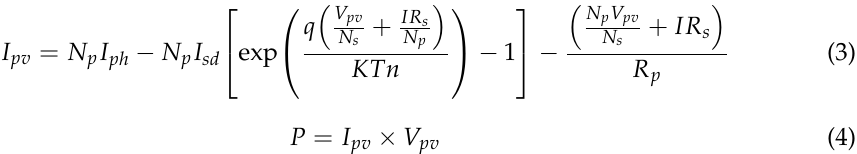
Figure 2. General photovoltaic module model.